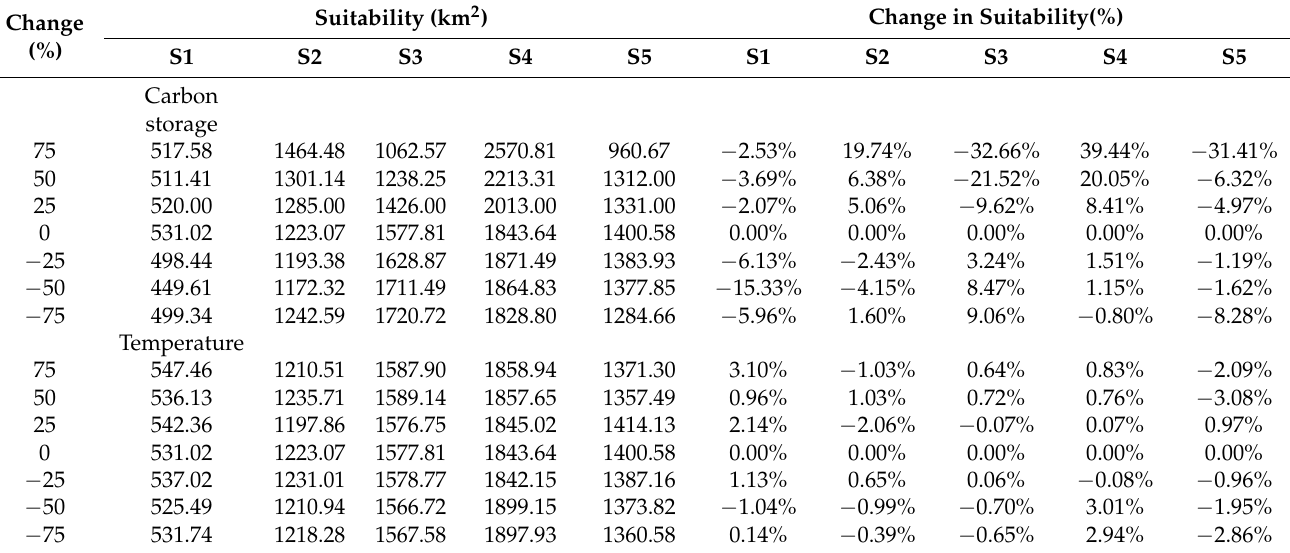
Table 6. Results from sensitivity analysis from fuzzy-AHP methods for the criterion ‘carbon storage’ and ‘temperature’ regarding About City Park Site Selection